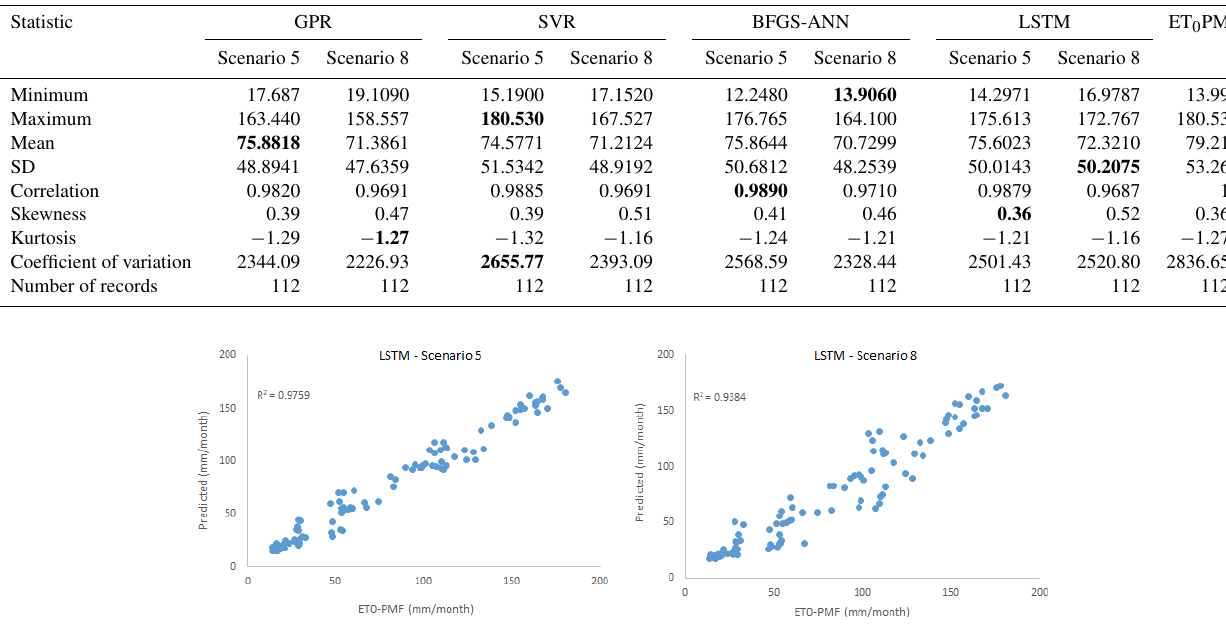
Figure 10. Scatter plots comparing LSTM-estimated and FAO56PM-estimated ET 0 in scenarios 5 and 8.